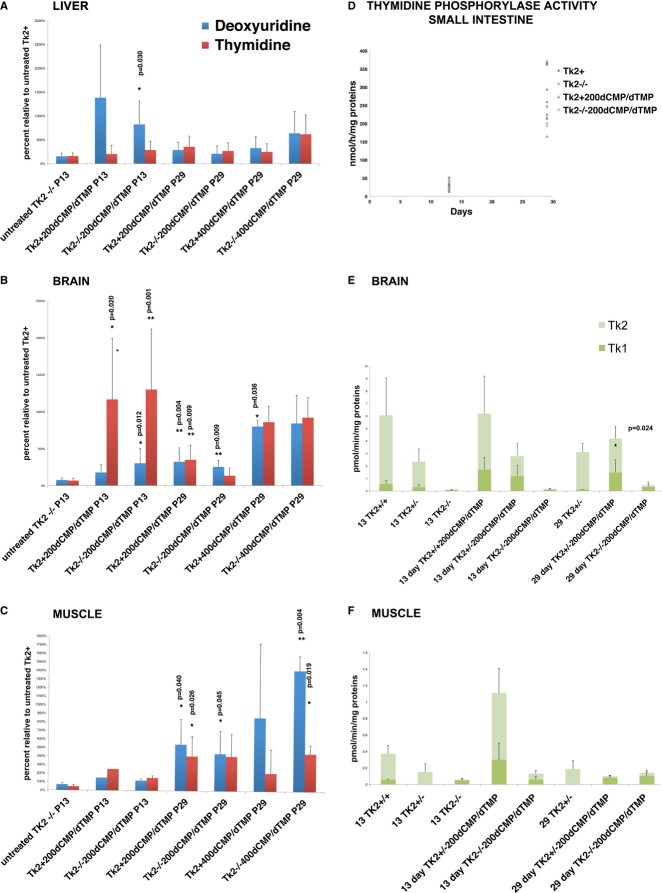
Metabolism of dCMP/dTMPA–C   Level of deoxyuridine and deoxythymidine in liver, brain, and muscle tissues was markedly higher at 13 days, but lower at 29 days. Deoxynucleoside levels are expressed as percents relative to age-matched untreated wild-type controls (mean ± SD) (Tk2−/−200dCMP/dTMP, Tk2+200dCMP/dTMP, Tk2−/−400dCMP/dTMP, and Tk2+400dCMP/dTMP versus untreated Tk2+; *P < 0.05;**P < 0.005; Unpaired t-test with Welch's correction; n > 3 mice for each group).D   Thymidine phosphorylase (TP) activity in small intestine of treated and untreated Tk2 mice showing dramatically increased activity at age 29 days relative to 13 days. Data expressed as nmol/h/mg-proteins (mean ± SD).E, F   Tk1 and Tk2 activities in brain and muscle tissues of treated and untreated mice showing increased Tk1 activity in treated mice. Data expressed in pmol/min/mg-proteins (mean ± SD) (Tk2+/+ versus Tk2+/+200dCMP/dTMP; Tk2+/− versus Tk2+/−200dCMP/dTMP; Tk2−/− versus Tk2−/−200dCMP/dTMP; *P < 0.05; Unpaired t-test with Welch's correction; n > 3 mice for each group). P = p-value.